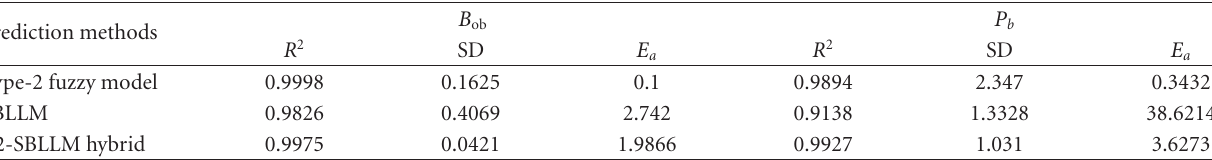
Table 3: Testing results for 782-dataset when predicting B ob and P b . R 2 : correlation coe ffi cient, SD: standard deviation, E a : average